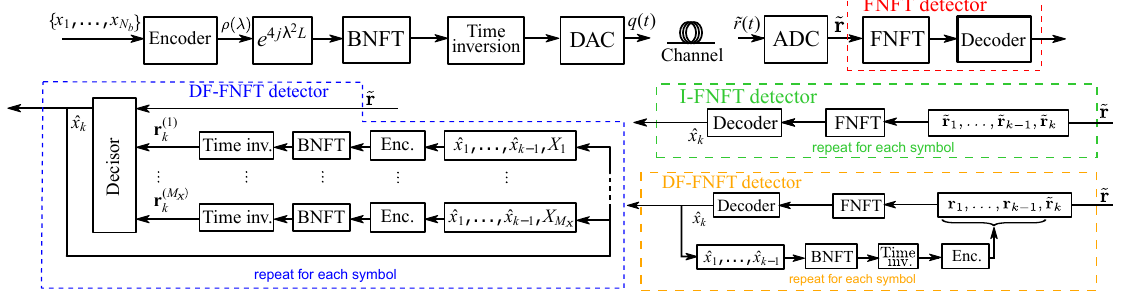
Figure 1. The nonlinear frequency-division multiplexing (NFDM) system with different detection strategies. The physical channel is a single-mode fiber of length L = 2000 km, attenuation α = 0.2 dB/km, GVD parameter β 2 = − 20.39 ps 2 /km, and nonlinear coefficient γ = 1.22 W − 1 km − 1 , along which ideal distributed amplification with spontaneous emission factor η sp = 4 is considered. The bandwidth of both the DAC and the ADC is 100